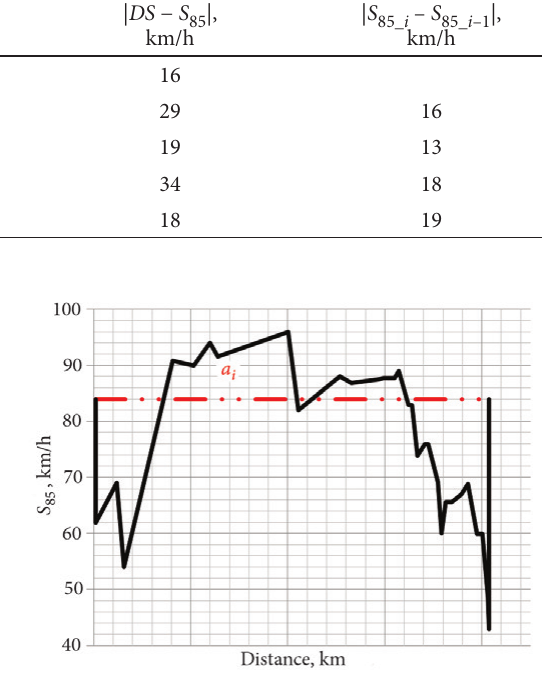
Table 2. Outcomes of the application of Lamm and Choueiri (1987) criteria for assessing the road consistency Road elements ID (Table 1)